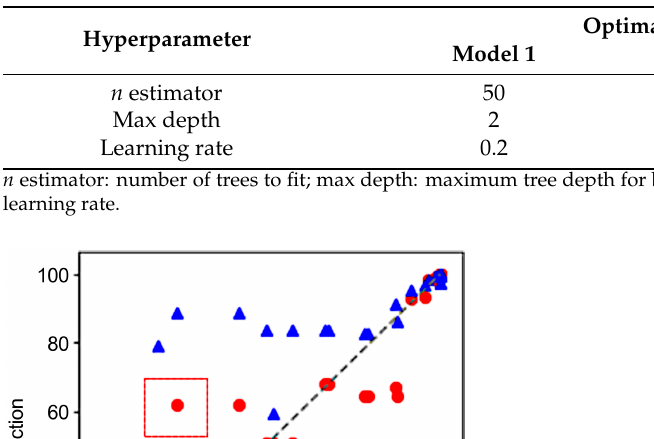
8 of 14 Table 3. Characteristics of the input variables. Variables